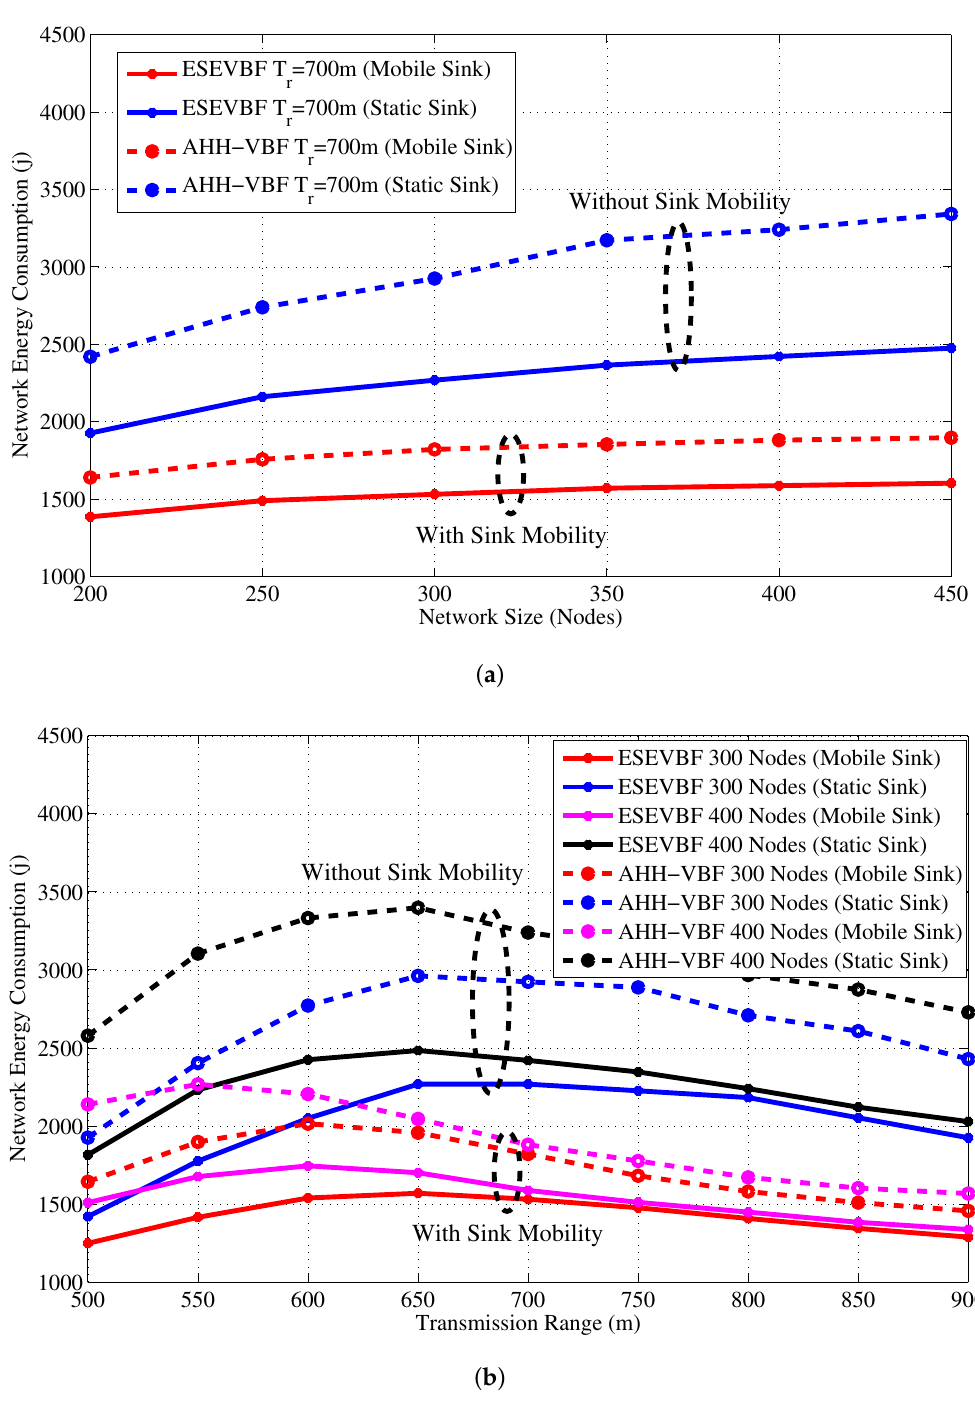
Figure 22. Network energy consumption in the static and mobile Sink network scenario for varying ( a ) network size ( b ) transmission